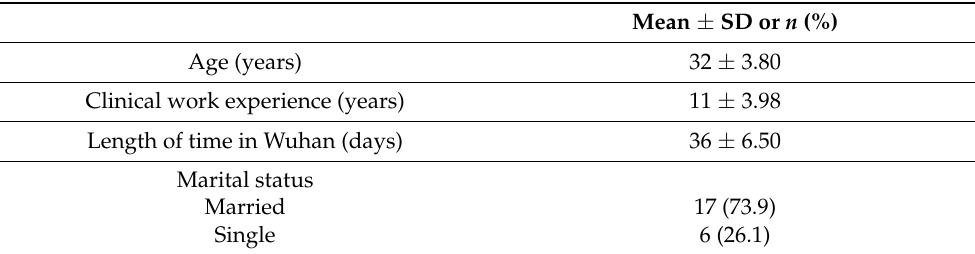
Table 2. Demographic characteristics of the study